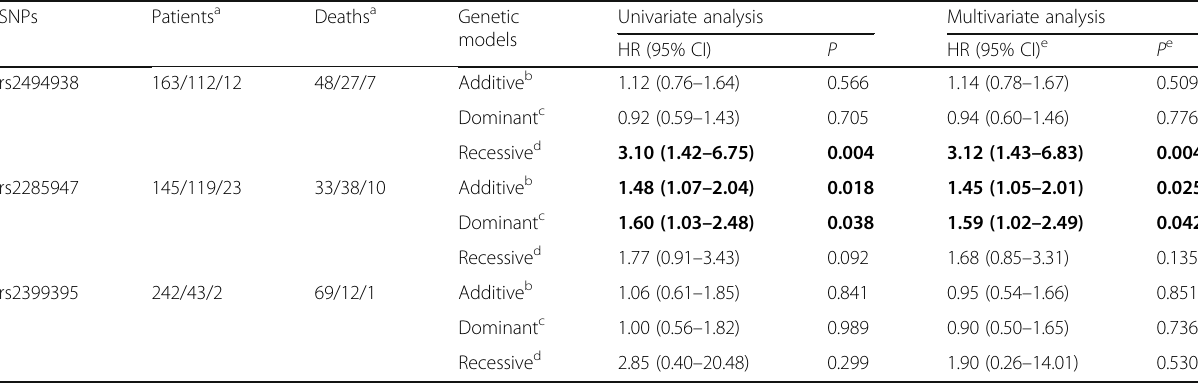
Table 2 Genotyping results with ESCC patients ’